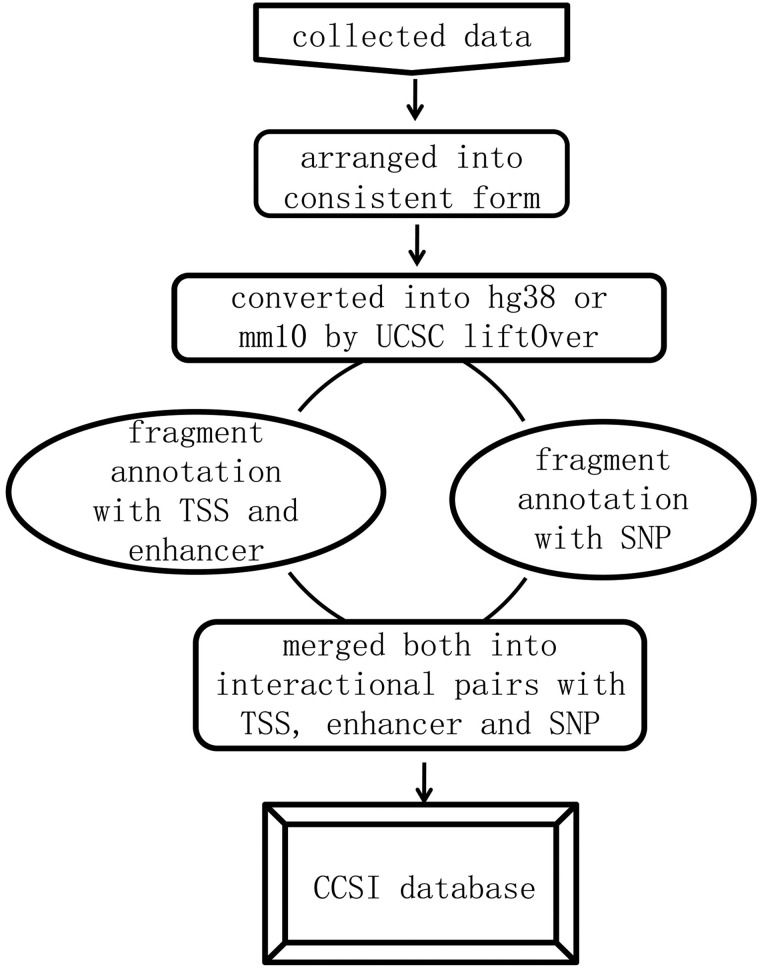
Framework of constructing CCSI database.